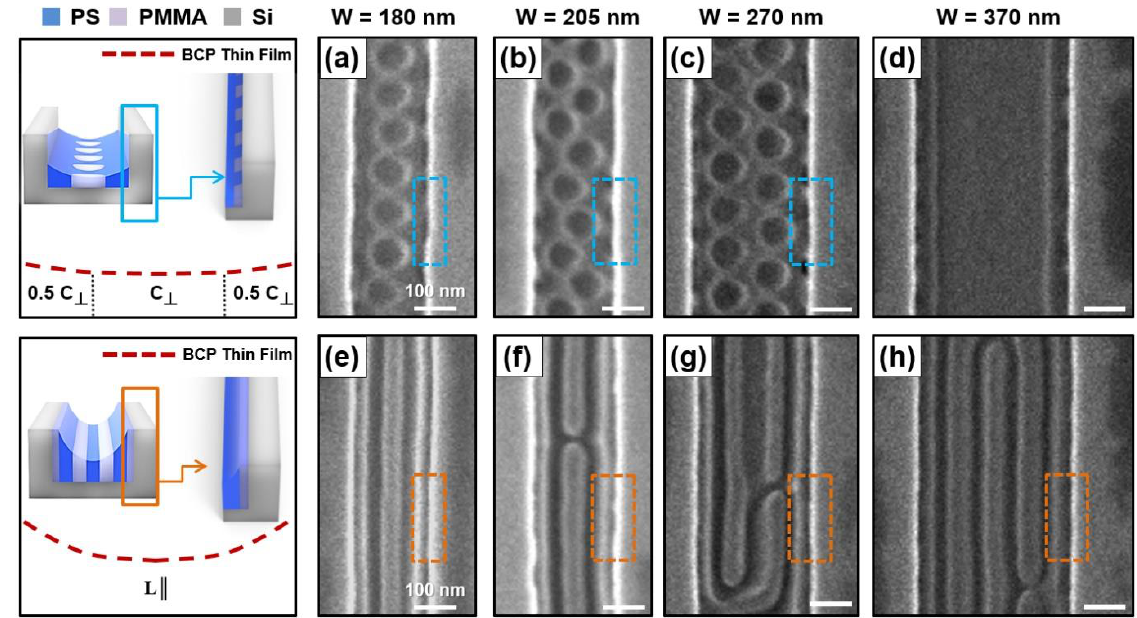
Figure 3. Top-view SEM images of BCP (PS- b -PMMA, M n = 105 – 106 kg/mol, L 0 = 109 nm) nanodomains with a 48- ( a – c ), 15- ( d ), and 96-nm-thick ( e – h ) thin film inside various silicon trenches.